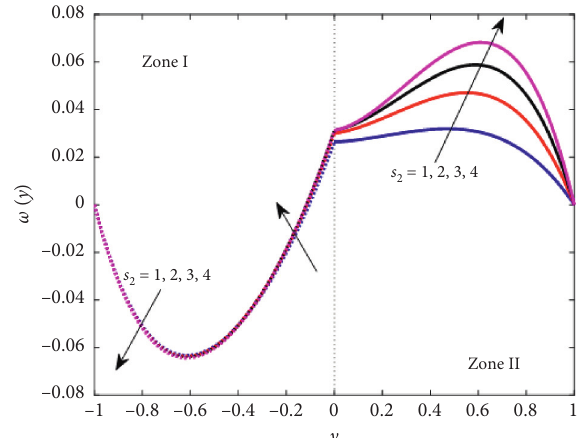
Figure 11: Microrotation profiles for various s